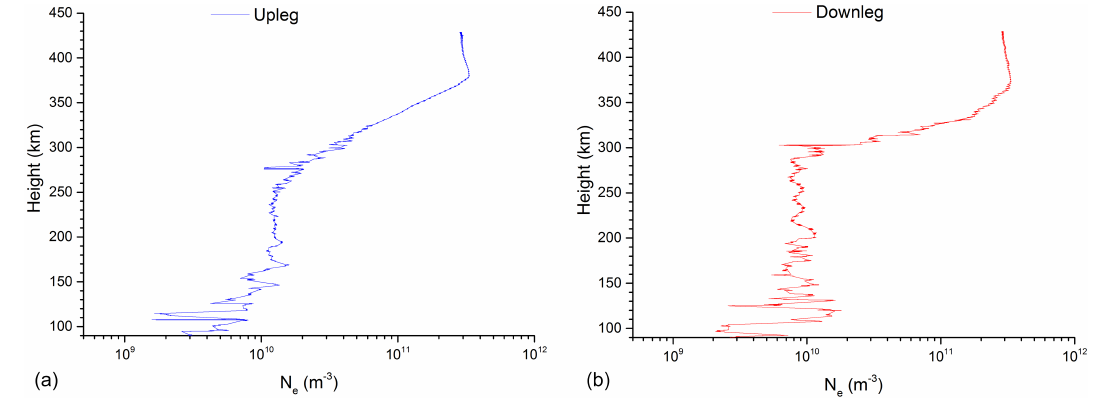
Figure 4. Electron density profiles obtained with a Langmuir probe data onboard a VS-30 Orion rocket on 8 December 2012, 19:00LT.